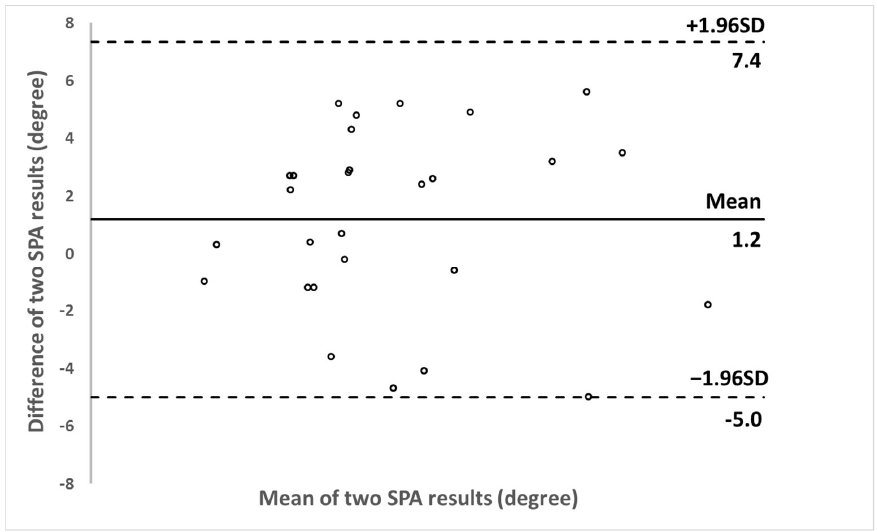
Figure 8. Bland-Altman plot between SPA results obtained by Scolioscan Air and Scolioscan.